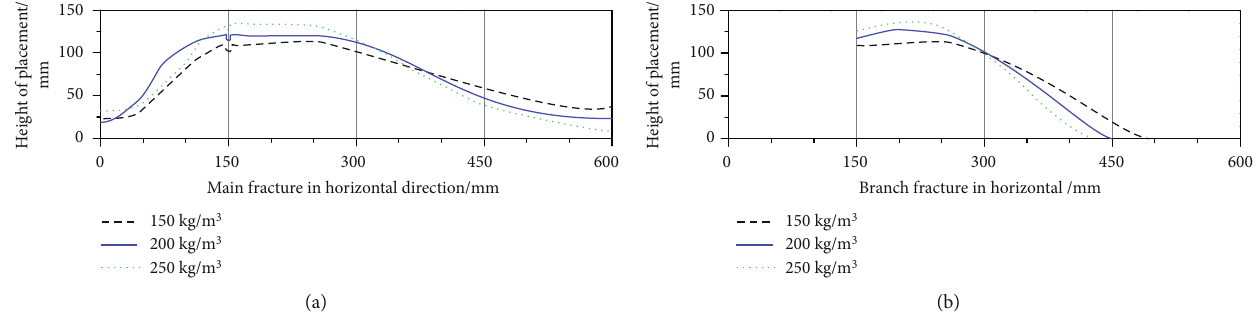
Figure 12: Proppant transport characteristics in the main fracture (a) and branch fractures (b) with di ff erent sand concentrations.